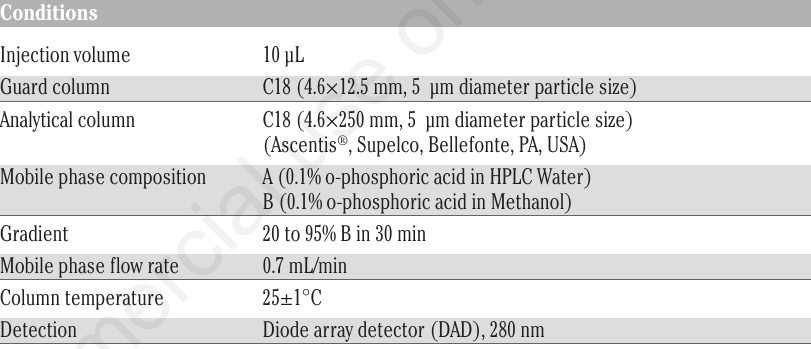
Table 2. High performance liquid chromatography conditions for the determination of phenolic